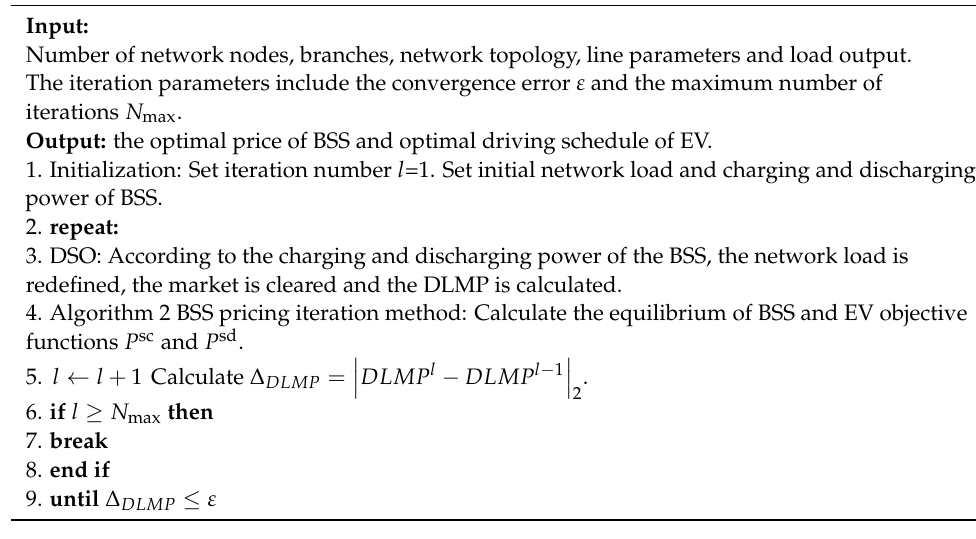
Algorithm 1. DSO–BSS–EV iteration